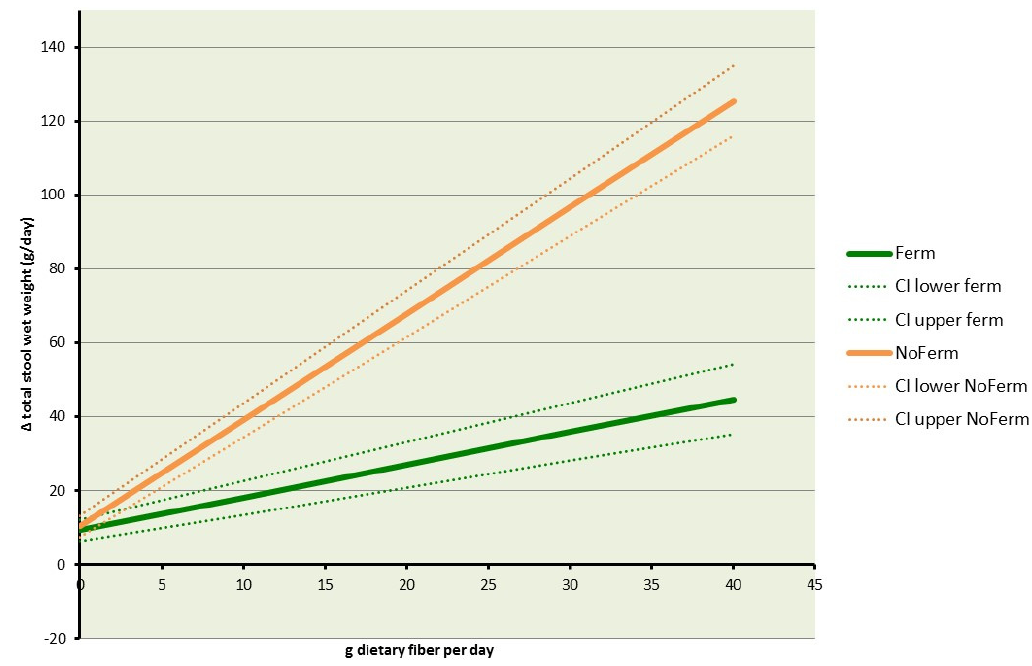
Figure 3. Changes in total fecal wet weight (g/g dietary fiber) and corresponding confidence intervals organized according to fermentability. Ferm: more fermentable; NoFerm: less fermentable; CI: confidence interval.